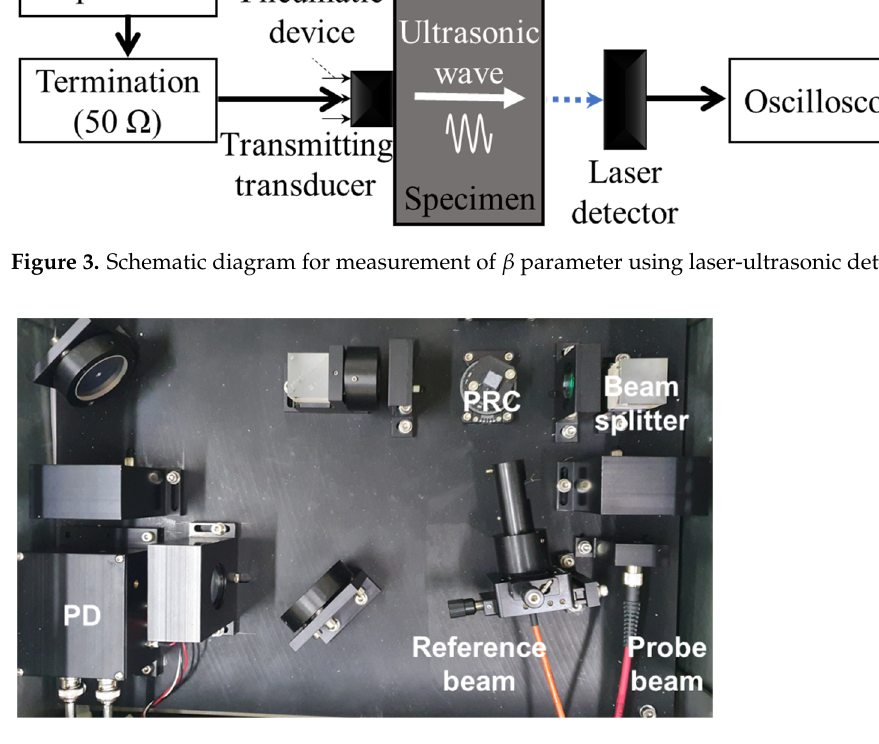
Figure 4. Picture of photorefractive interferometric system.